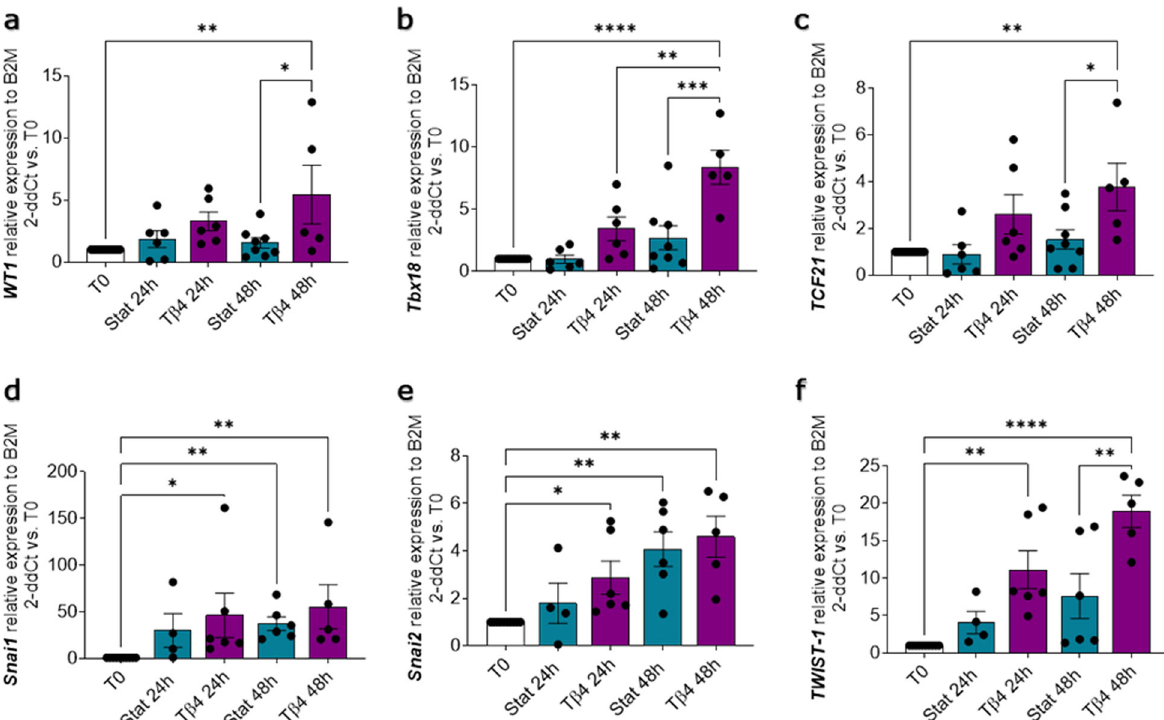
Fig. 10 T β 4 stimulates epicardial gene expression and EMT in the slices. Gene expression analysis showing relative expression of epicardial transcription factors WT1 ( a ), Tbx18 ( b ), and TCF21 ( c ) and EMT markers Snai1 ( d ), Snai2 ( e ), and TWIST-1 ( f ), after 24 h and 48 h of control static culture (Stat) and thymosin β 4 (T β 4) treatment, as compared to freshly cut slices (T0). N of pigs = 3 – 7, number of slices displayed in graphs. All graphs display data as mean ± SEM. * p ≤ 0.05, ** p ≤ 0.01, *** p ≤ 0.001, **** p ≤